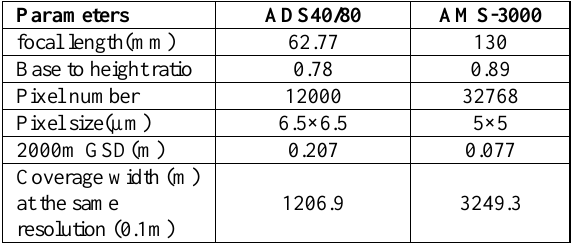
Table 1 The parameter comparison of ADS40/80 and